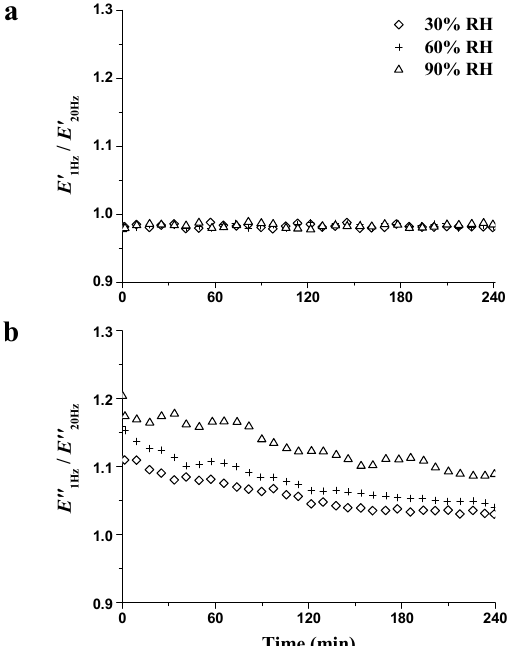
Figure 11. Changes of E ′ 1Hz / E ′ 20Hz ( a ) and E ′′ 1Hz / E ′′ 20Hz ( b ) during the RH isohume periods (30%, 60%, and 90% RH).